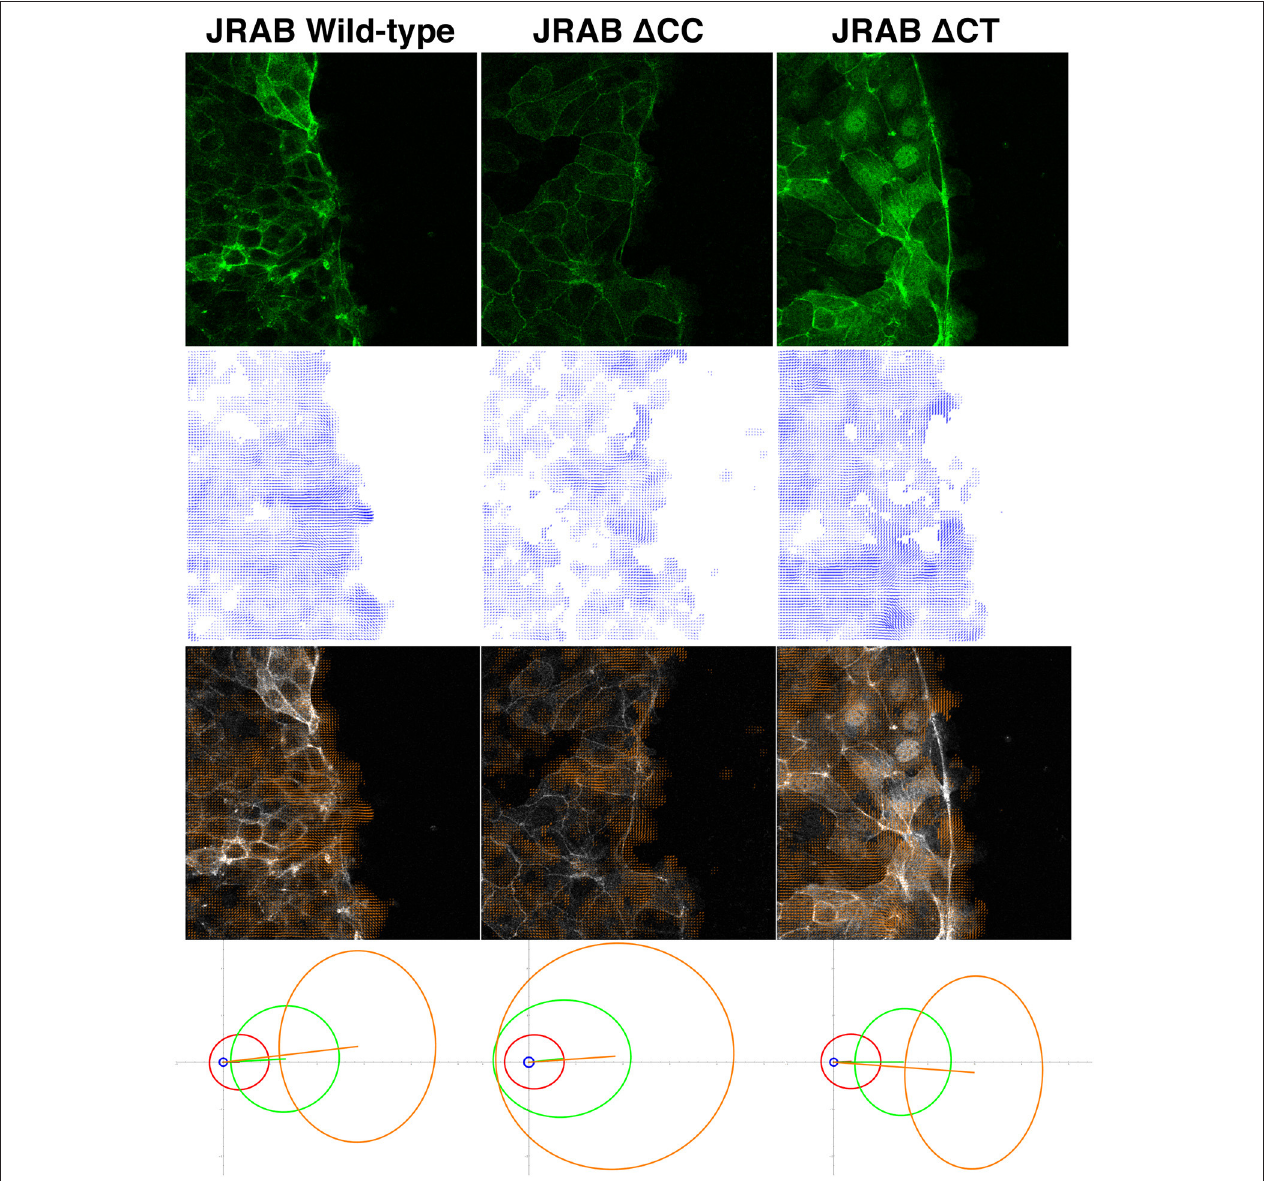
FIGURE 1 | Example of OF analysis of collective cell migration. Top row: live-cell images of cell groups expressing GFP-tagged JRAB wild-type and two mutants. Second row: estimated velocity fields obtained via OF, corresponding to the images in the top row. Third row: overlays of the top and second-row images. Fourth row: PCA results (four different subsets of velocity vectors) corresponding to the datasets represented by the top-row images. More than two billion vectors extracted from 27 time-lapse sets consisting of 7,700 images were employed in the PCA. Each ellipse shows how magnitude and direction of the corresponding velocity vector set varies in 2D space. Coordinate origin represents no movement, and increasing distance from the origin indicates greater velocity. Hence, each ellipse in JRABwt (bottom-left image), especially the two ellipses in the high-speed region, is more concentrated toward the left, which is the direction of cell migration. Thus, JRABwt is more efficient than the other mutants. For more detailed statistical analysis and discussion, see our recent work (Sakane et al., 2016); these figures were adapted from that paper with permission from